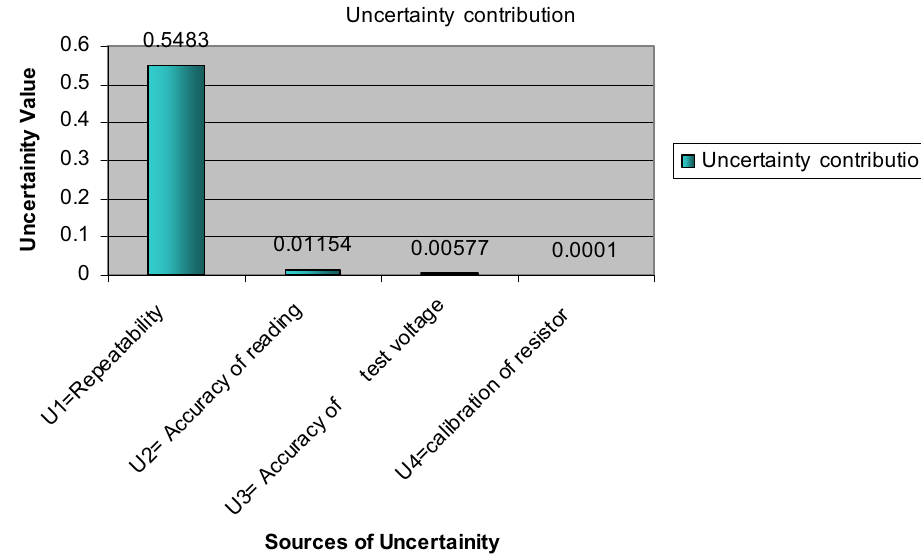
Fig. 8. (Color online) Effects of various factors for